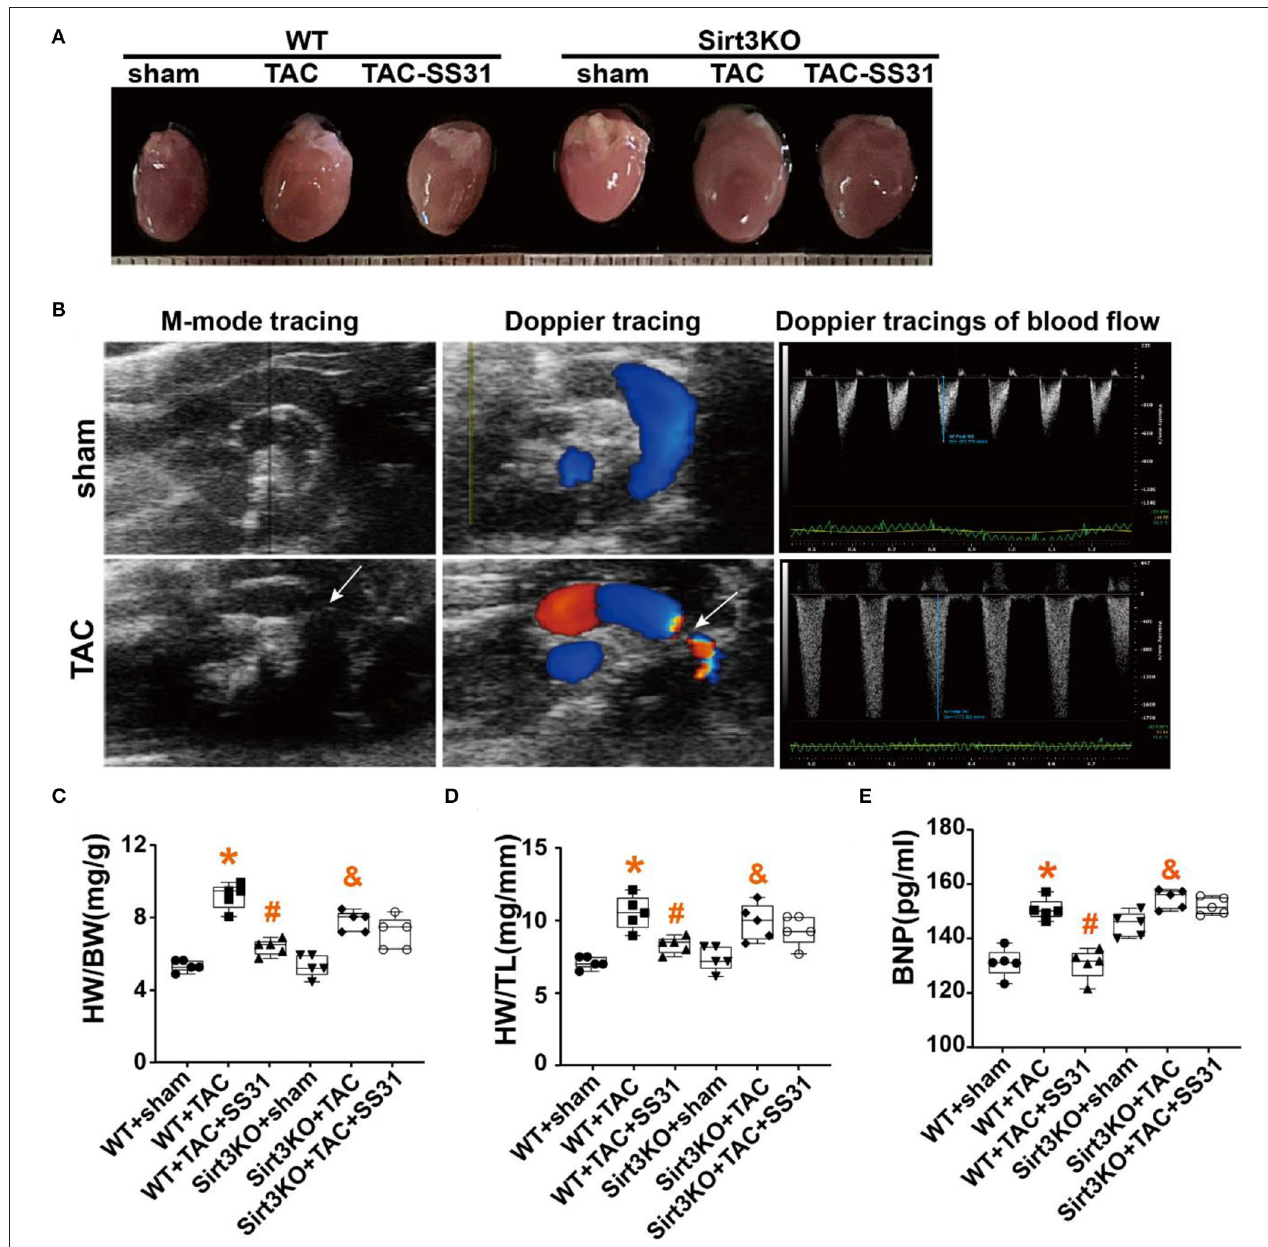
FIGURE 1 | The effect of SS31 on heart function. (A) Representative size of the mice heart in different groups; (B) Echocardiography was performed on the mice with sham or TAC surgery, Representative M-mode tracing shows the constriction of the aortic arch (white arrow), and the Doppler ultrasound image shows the blood flow and blood flow velocity; (C) the ratio of heart weight (mg) to body weight (g) (HW/BW); (D) Heart weight to tibia length ratio (HW/TL). (E) The level of serum brain natriuretic peptide (BNP) in mice detected by ELISA. (The results are expressed as the means ± SEM, n = 5;* p < 0.05 vs. WT + sham group; # p < 0.05 vs. WT + TAC group; & p < 0.05 vs. Sirt3KO + sham